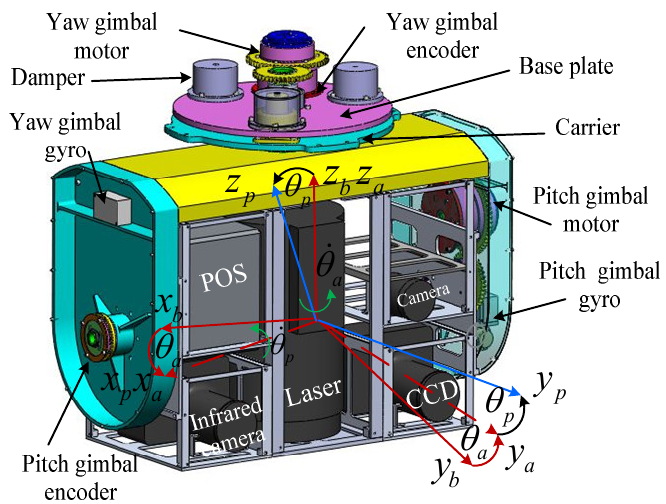
Figure 1. Two-gimbal ISP configuration diagram.